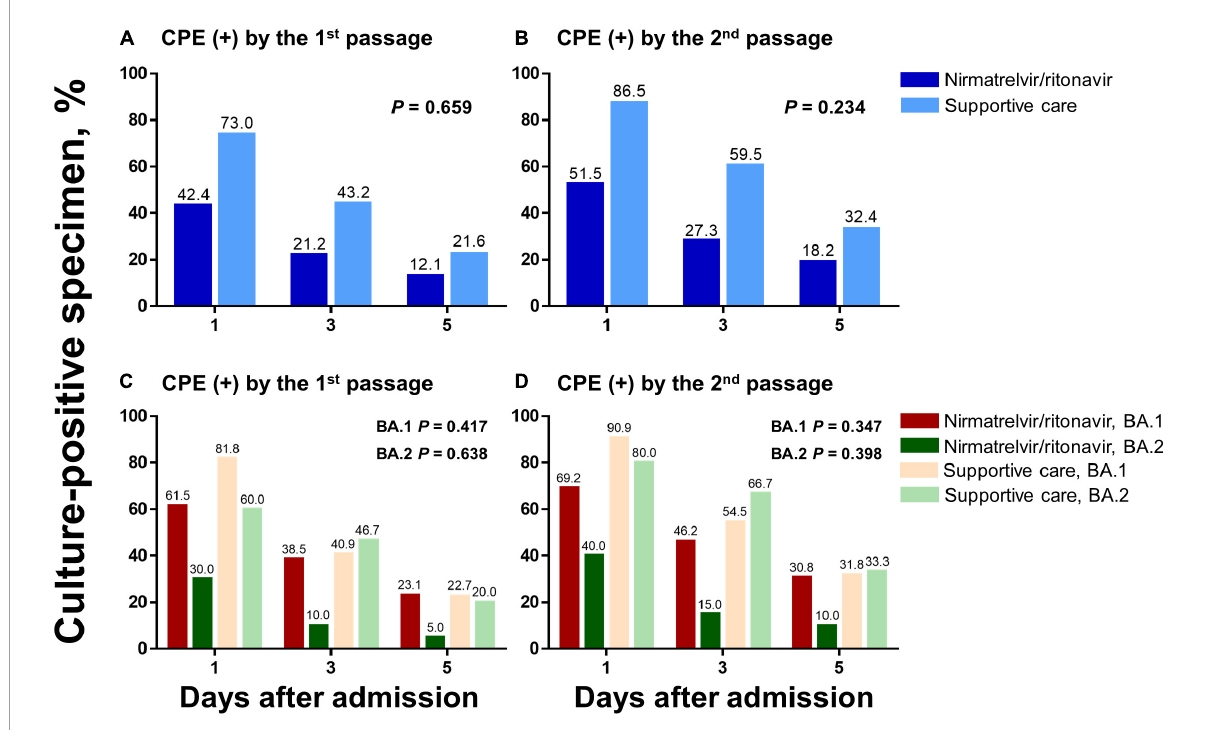
FIGURE3 Changes in culture-positive viral shedding in response to nirmatrelvir/ritonavir treatment compared with supportive care. Changes in culture-positive viral shedding are compared in the nirmatrelvir/ritonavir and supportive care groups, among the total study population (A,B) and according to the viral subtypes (C,D) . Two different criteria for positive culture were applied: (1) CPE-positive by the first cell passage (a and c) and (2) CPE-positive by the second cell passage (B,D) . CPE, cytopathic